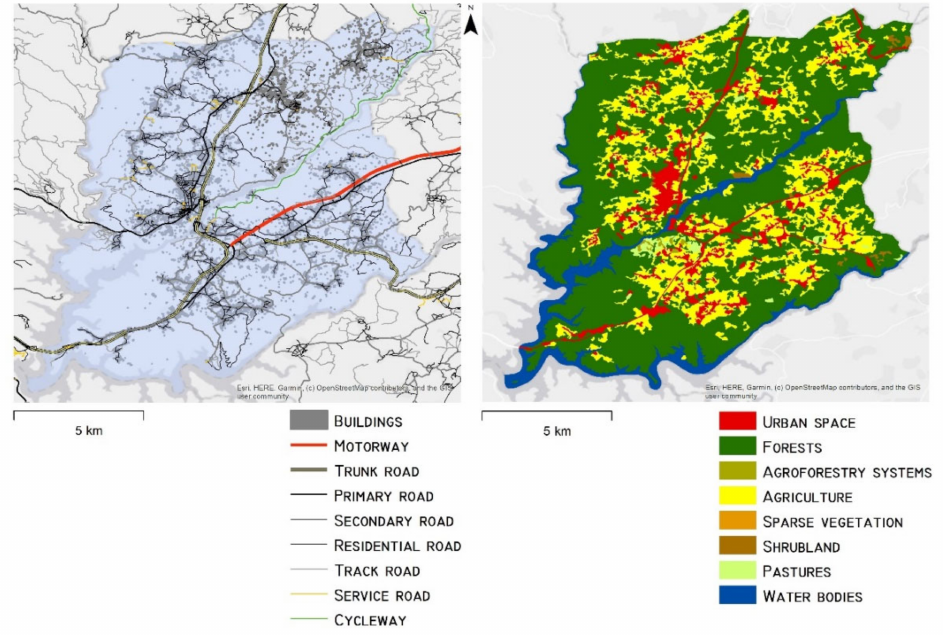
Figure 2. Municipality road and land use structure